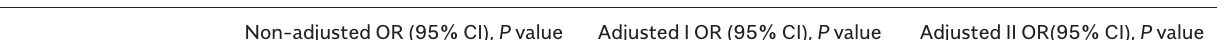
Table 2. The Association Between Vitamin C (mg/dL) and NAFLD